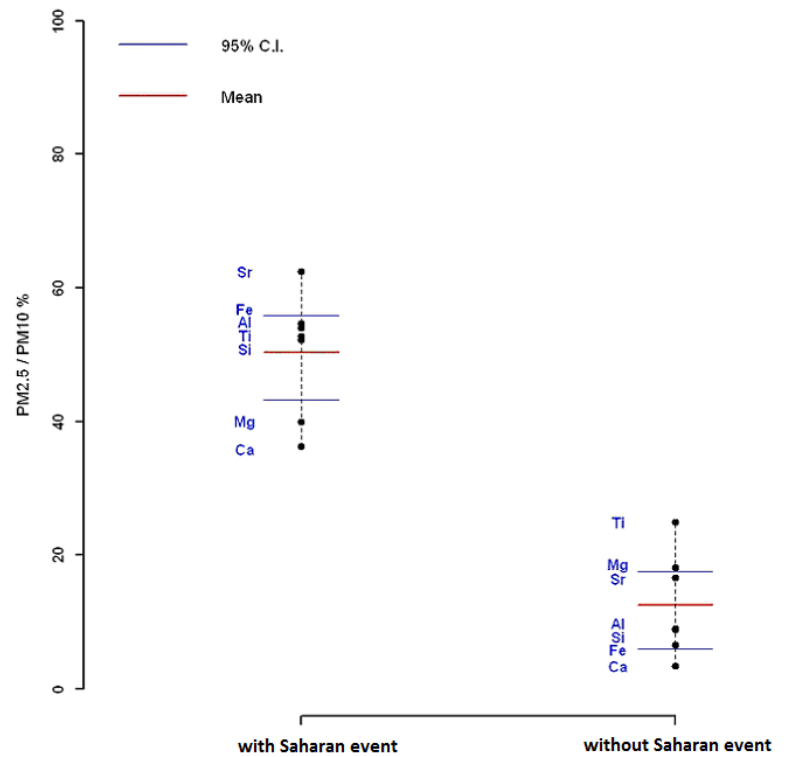
Figure 1. Distribution of PM 2.5 /PM 10 ratios for the considered elements. The mean relating to days with a Saharan event is at about PM 2.5 /PM 10 = 50.32% with the 95% C.I. (43.24%, 55.96%). The mean relating to days without a Saharan event is at about PM 2.5 /PM 10 = 10.74% with C.I. (6.03%, 17.67%).